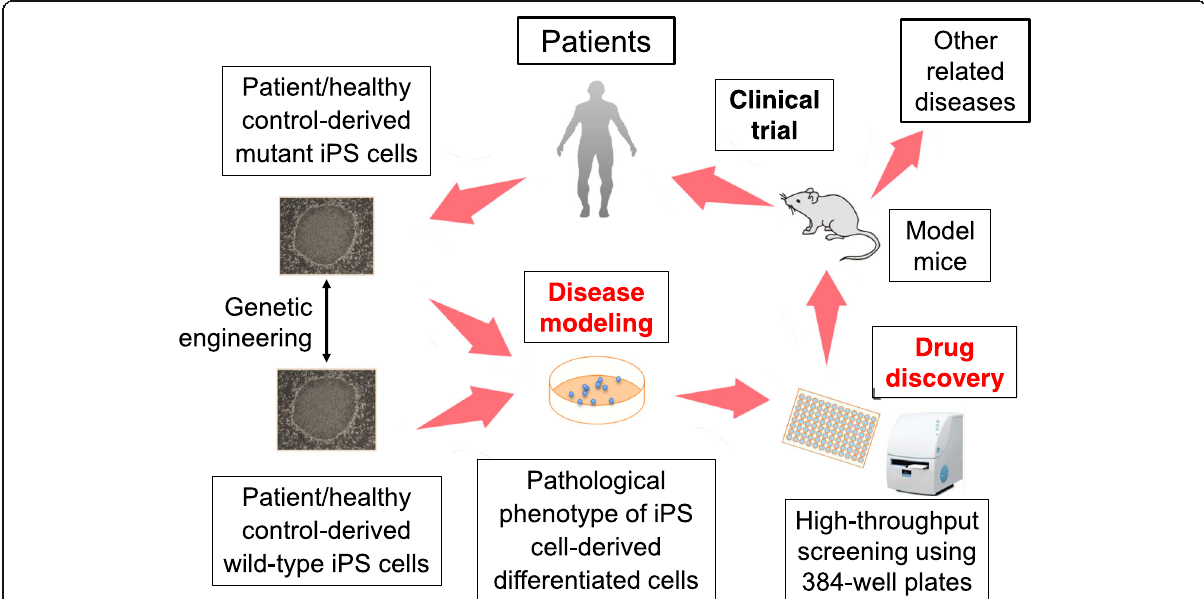
Fig. 3 Strategy of disease modeling and drug discovery using iPS cells. If a major aspect of the disease phenotype is reproduced in vitro using a genetically engineered pair of mutant and wild-type iPS cells (disease modeling), a compound which can recover the phenotype is searched with high-throughput screening and provided for clinical trial following its application to any model mice in vivo (drug